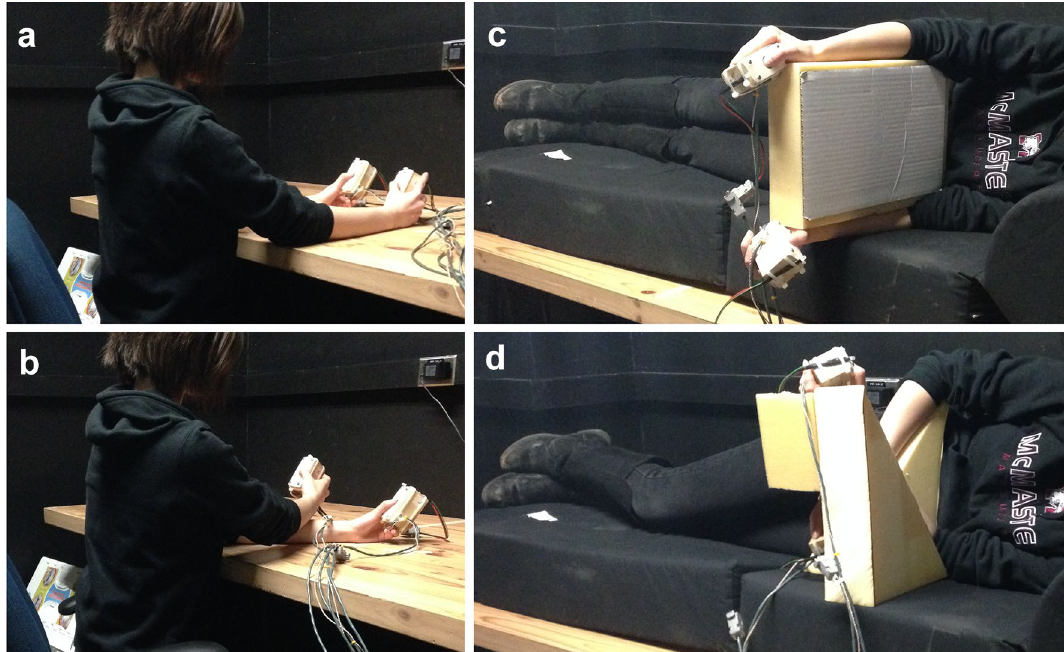
Figure 1. Hand and body postures used for Experiments 1 and 2. ( a ) Participant sitting upright with hands uncrossed, ( b ) participant sitting upright with hands crossed, ( c ) participant lying on left side with hands uncrossed, and ( d ) participant lying on left side with hands